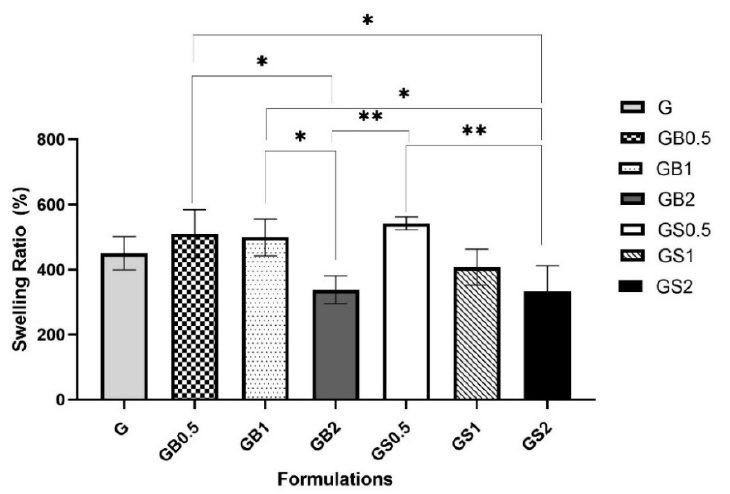
Figure 9. Comparison of the swelling ratio (%) calculated for meshes of different formulations (** p < 0.01, * p < 0.05).